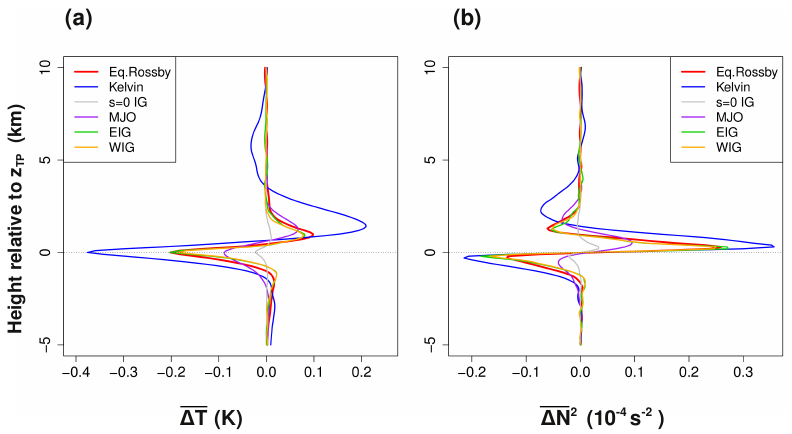
Figure 6. Winter (DJF) average signature of the different wave types, as the mean anomalies of (a) temperature (cid:49)T and (b) static stability (cid:49)N 2 in the equatorial zonal-mean vertical profiles (10 ◦ S–10 ◦ N).